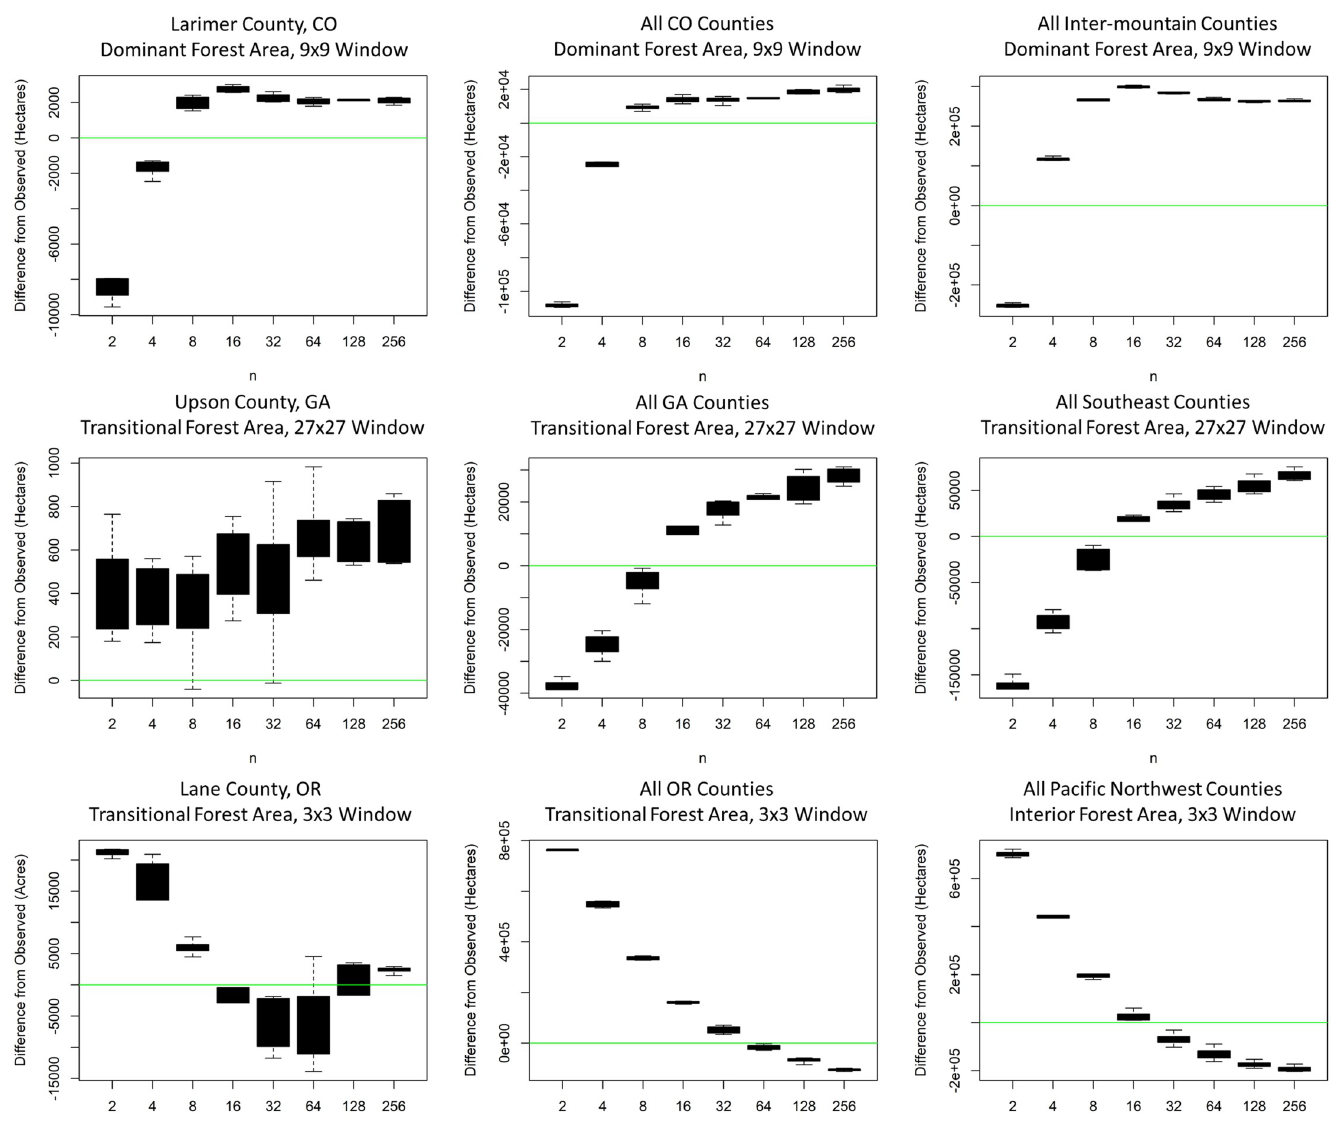
Fig 7. Coverage of observed forest patterns. Differences between the total observed forest fragmentation and that derived from realizations, with respect to choice of the seeding size, n , and the scale of aggregation for results. Three example forest fragmentation classes (Table 3; Fig 5) are shown here. The green line represents a difference of 0 acres between the observed forest area and realized forest area, for forested pixels of the given fragmentation class at the given scale. Each boxplot represents six realizations per choice of n